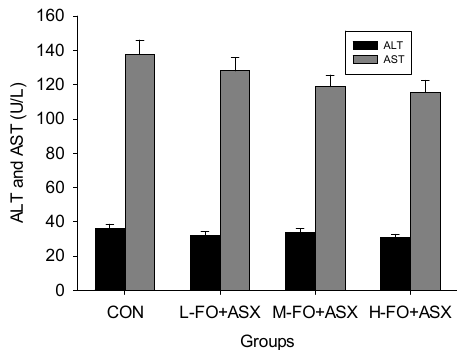
Figure 1. Effects of flaxseed oil (FO) and astaxanthin (ASX) on plasma alanine aminotransferase (ALT) and aspartate aminotransferase (AST) in rats fed a high-fat diet. CON: high-fat diet group; L-, M- and H-FO + ASX: low, moderate, and high FO and ASX groups. Bars represent means ± SEM ( n = 10/group).